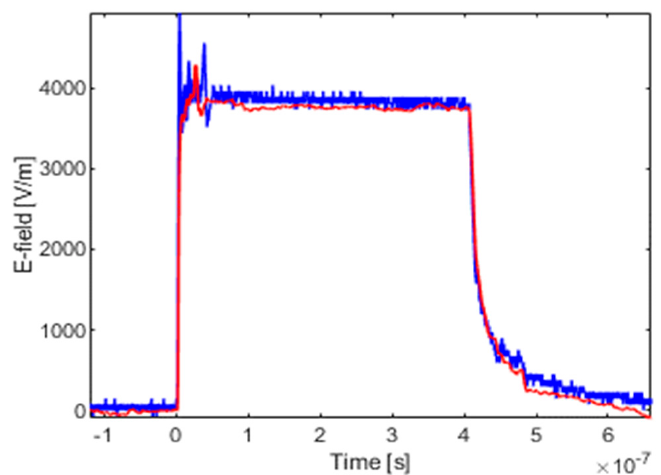
Figure 10. Experimental verification of square wave.